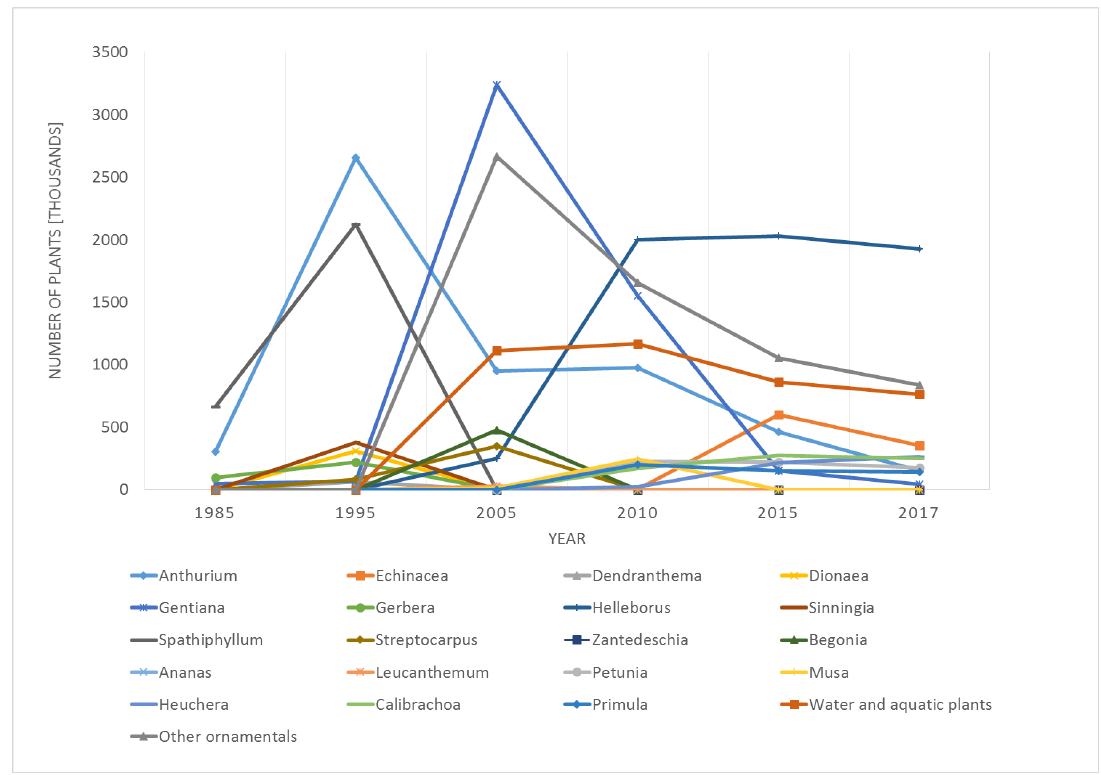
Fig. 3: Production of selected ornamentals from 1985 to 2017 (stated by ADIVK members, voluntary basis).